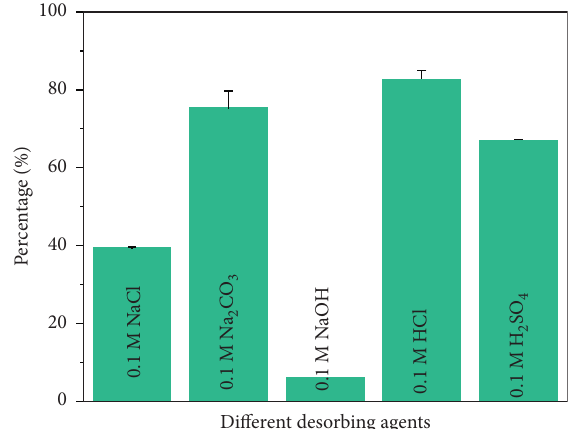
Figure 12: Percentage of phosphorus released from ceramsite using different desorbing agents (equilibrium: pH � 7, t � 10min, adsorbent dosage � 1g · L − 1 , 120rpm, initial phosphorus concentration � 10mg · L − 1 , and 25 ° C).